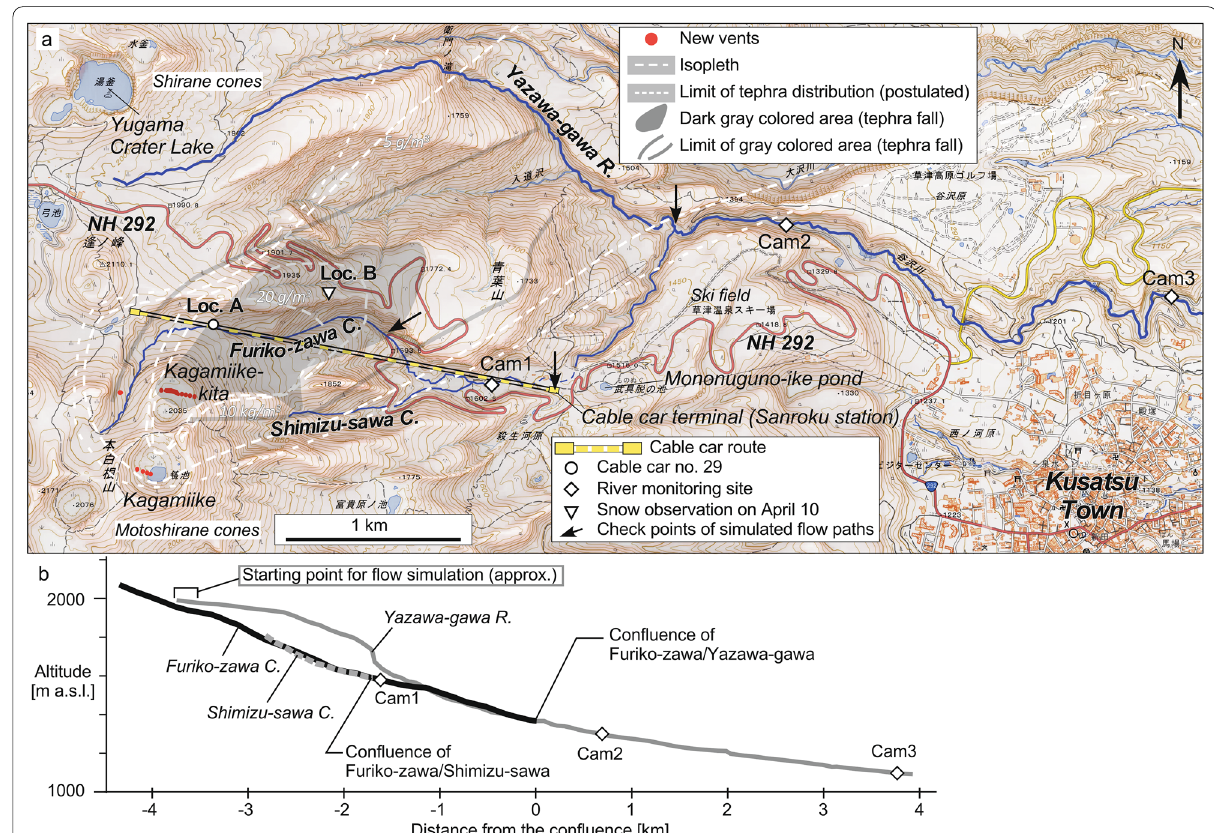
Fig. 2 The river system east of Kusatsu-Shirane (Mts. Shirane and Motoshirane) volcano. a Key locations of sampling, observation, and monitoring. The topographic map is based on open source data provided by the Geospatial Information Authority of Japan (GSI). Distribution of tephra and isopleths and dark gray-colored and limit of gray-colored areas indicating ash covered surfaces are based on a preliminary report by the Geological Survey of Japan (released on January 26, 2018) and the Joint Research Team for ash fall in Kusatsu-Shirane 2018 eruption (released on 6 February 2018). New vent locations after GSI data (https:// www. gsi. go. jp/ BOUSAI/ kusat sushi rane- index. html). b Schematic longitudinal profiles of